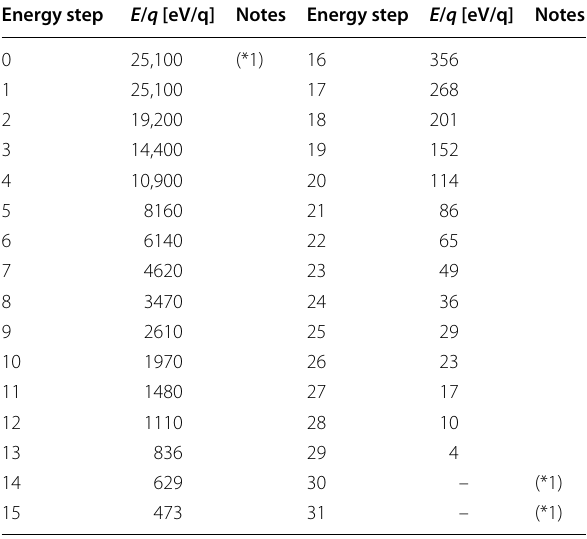
Table 2 E / q setting of energy